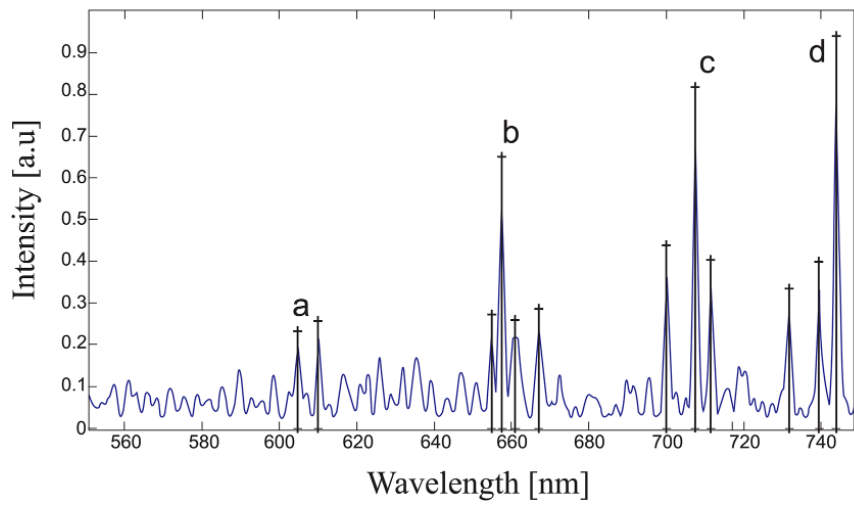
Figure 8. Photoluminescence spectrum of ZnSe co-doped with Eu 3+ /Yb 3+ at 20 K without the ZnSe contribution. a is the emission line of pure ZnSe and b, c, d are the new emission lines due to dopants.